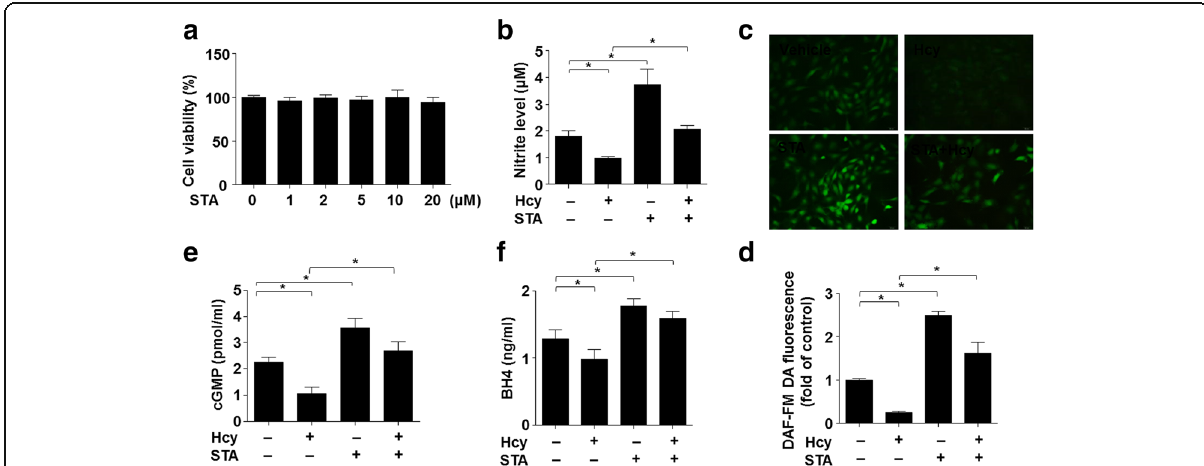
Fig. 3 STA increased NO, cGMP and BH4 production. a BAECs were treated with indicated concentrations of STA for 24 h, and cell viability was measured by using MTT. b BAECs were pre-incubated with STA (10 μ M) or vehicle for 12 h, and then exposed to Hcy (500 μ M, 12 h). NO concentration in supernatants was measured by using the Griess reagent. c Intracellular NO was detected by using DAF-FM probe (40 × objective). d The mean fluorescence intensity was evaluated as in ( c ). e Rat thoracic artery rings pre-incubated with STA or vehicle were exposed to Hcy. The cGMP production was measured by using an enzyme immunoassay kit. f Intracellular levels of BH4 were measured by using BH4 ELISA Kit. Data shown were mean±SEM, n =5, * P